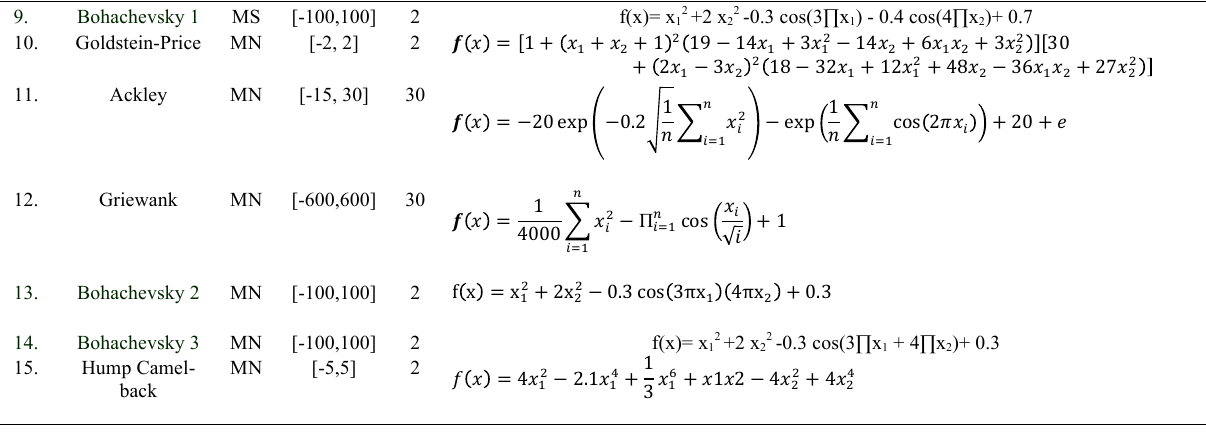
TABLE II O BJECTIVE F UNCTION V ALUES OBTAINED BY VARIOUS A